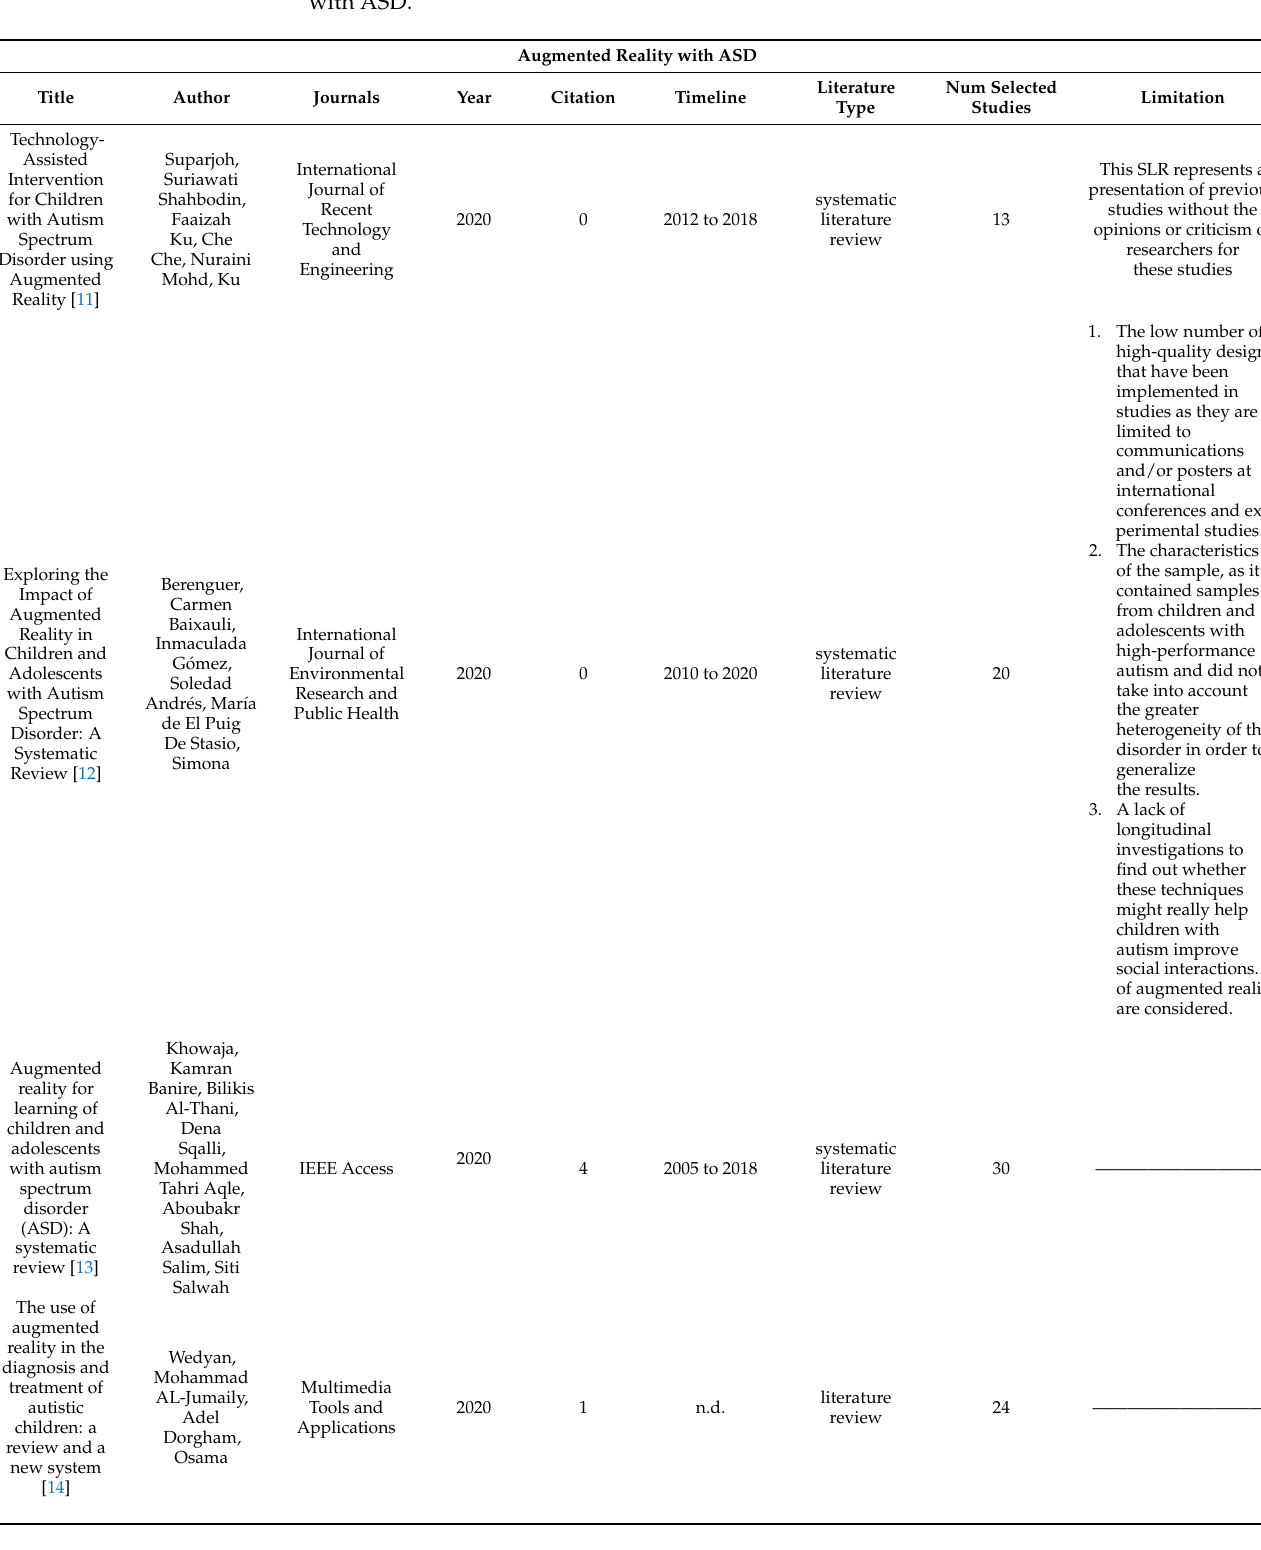
Table 1. Related surveys to the augmented reality environment and serious games with people with